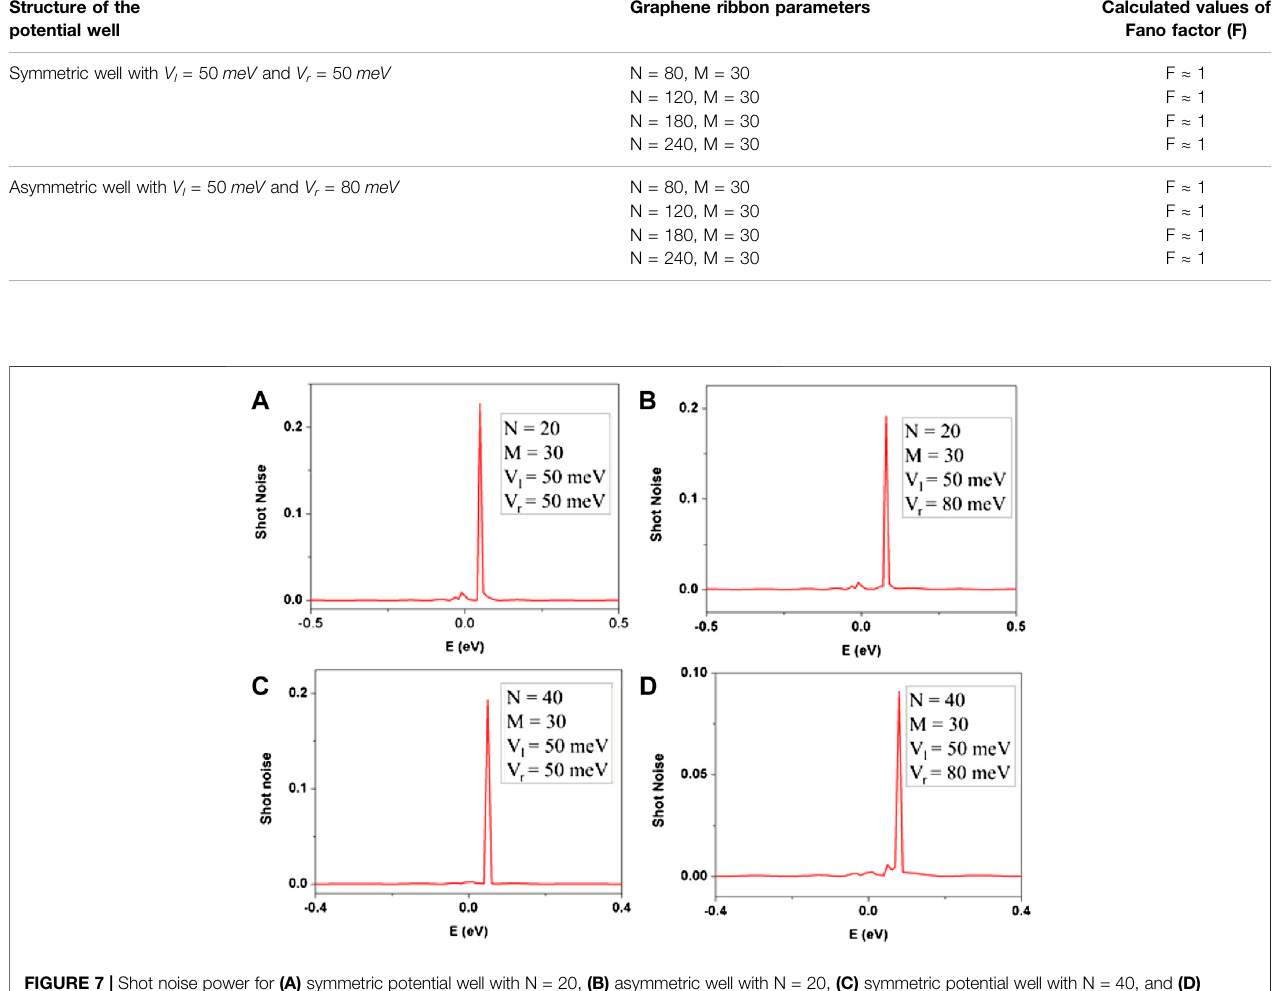
Frontiers in Physics |